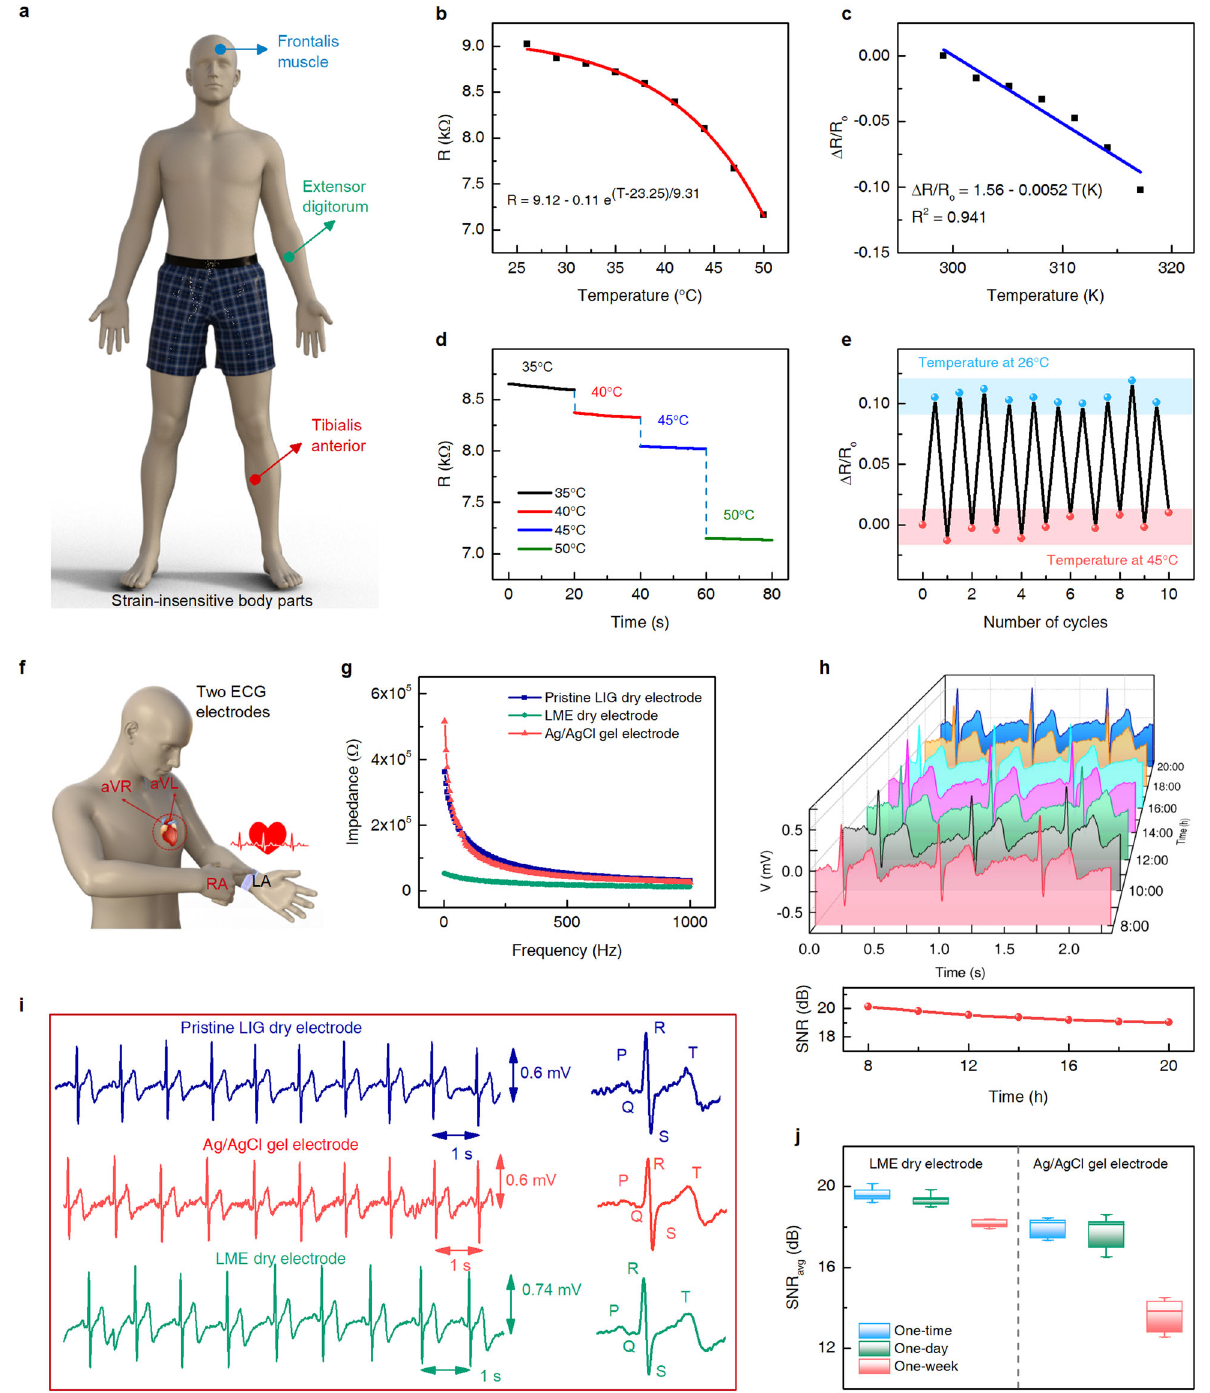
Fig. 5 Physiological signals measurement. ( a ) Illustration of strain-insensitive body parts for temperature measurement. ( b ) Resistance response of LIG/MXene-Ti 3 C 2 T x @EDOT composite as a function of temperature. ( c ) Calculation of thermal index as temperature sensitivity. ( d ) Response of the temperature sensor at physiological temperature range. ( e ) Temperature discrimination ability. ( f ) Illustration of ECG detection mechanism. ( g ) Comparison of contact impedance spectra as a function of frequency. ( h ) Long-term ECG monitoring (top) and their SNR measured for 12 h (bottom). ( i ) Long-term ECG monitoring for LIG, LIG/MXene-Ti 3 C 2 T x @EDOT, and Ag/AgCl gel electrode. ( j ) Comparison of SNR of our sensor with Ag/AgCl gel electrode over one (Supplementary Fig. 9a), skin-electrode impedance decreases with 1 kHz. For the skin-electrode impedance measurement, two increased frequency. The LME electrode exhibited a signi fi cantly identical LME electrodes were put on the skin at a distance of lower skin-contact impedance of 51.08 k Ω at 10 Hz (Supplemen- 3 cm apart and impedance spectra were measured. As evident tary Fig. 9b), lower than that of the Ag/AgCl electrode (417.86 k Ω ). from the equivalent circuit model of the dry electrode